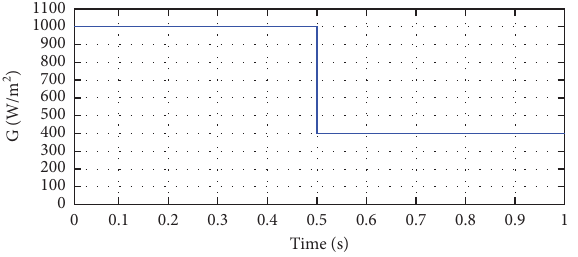
Figure 14: Solar irradiation